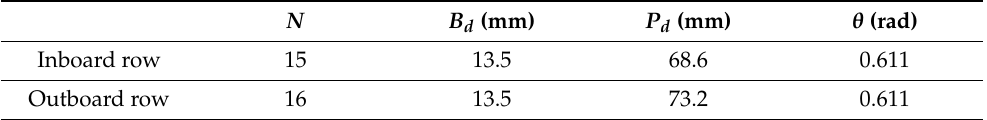
Figure 1. Automotive wheel bearing: ( a ) internal structure and ( b ) assembly with main components. Table 1. Design specifications of the wheel bearing.